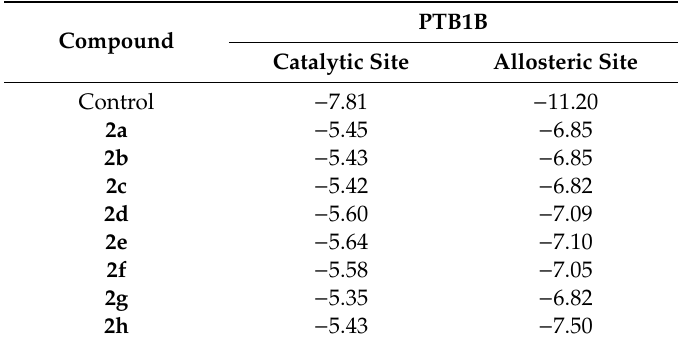
Figure 7. The detailed interactions of 2h at the catalytic binding site ( a ) and the allosteric binding site of PTB1B ( b ). Table 4. Estimated binding free energy (kcal / mol) calculated from docking simulation for control docking and compounds 2a – 2h with PTB1B.